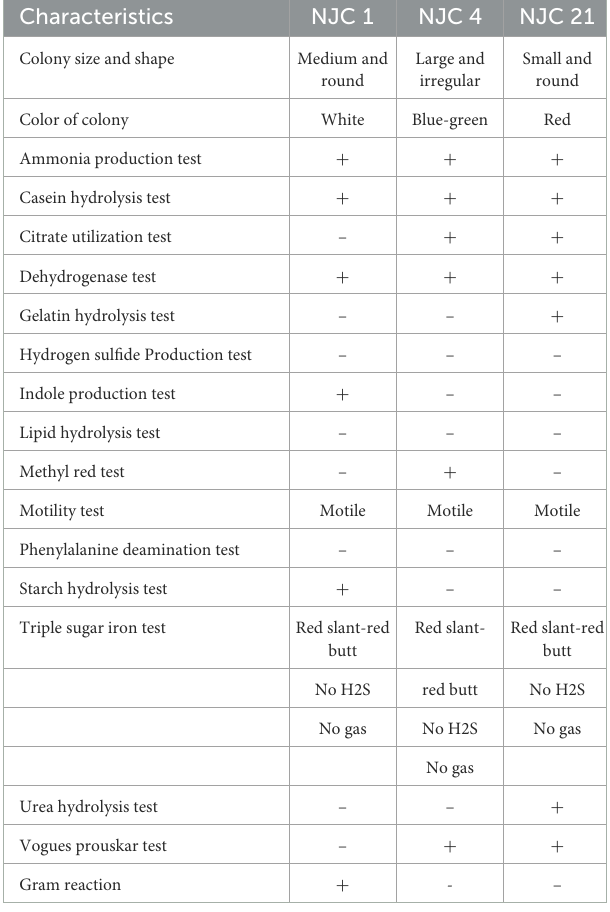
Large and Small and round irregular round